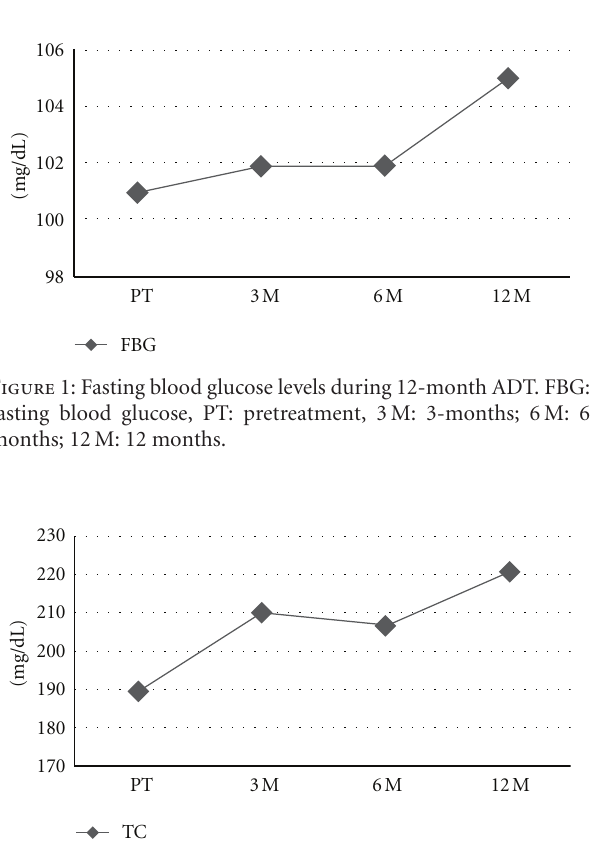
Figure 2: TC changes during ADT. TC: total cholesterol, PT: pre- treatment, 3 M: three months; 6M: six months; 12M: 12